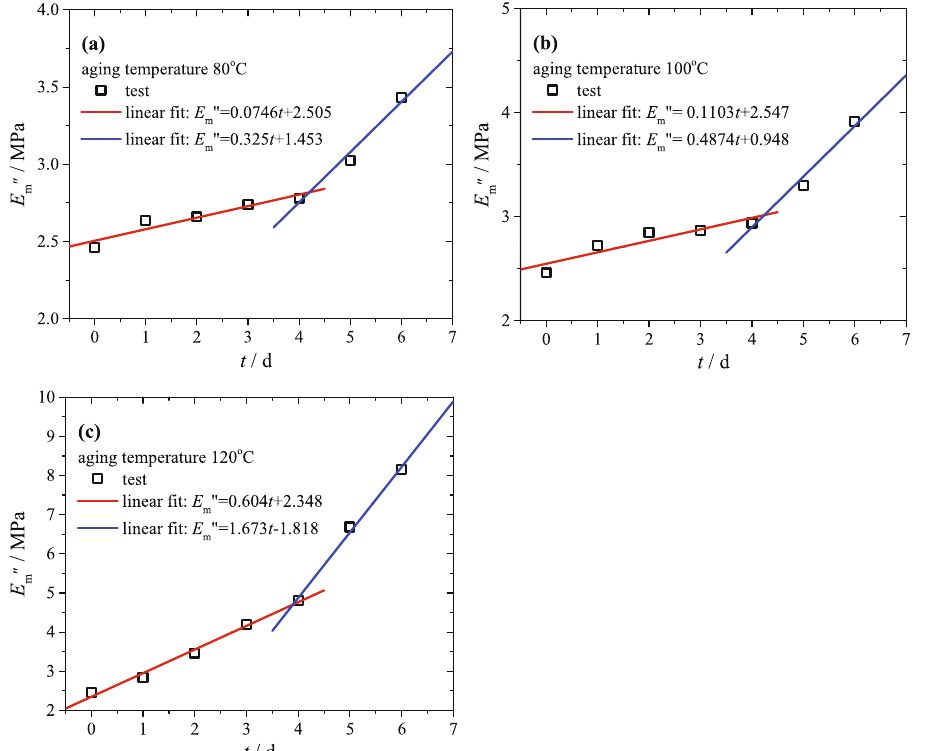
Fig. 4 Variation of parameter E 00 with aging time. Scatters are parameter E 00 m temperature 80 ℃ , b the results for aging temperature 100 ℃ , c the results for aging temperature 120 ℃